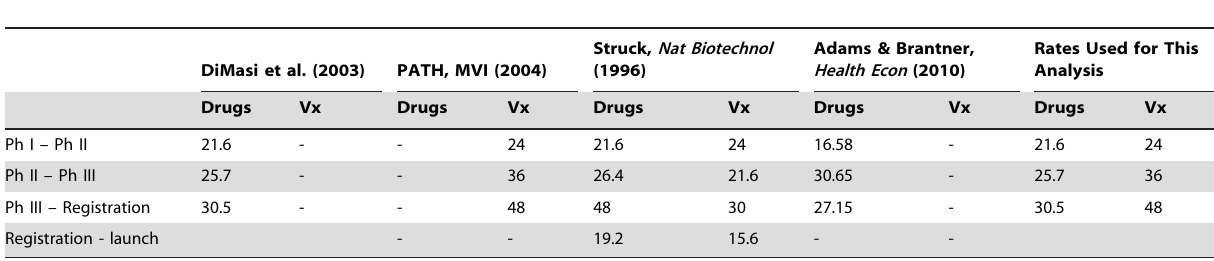
Table 2. Average timelines for development from various sources (in months).